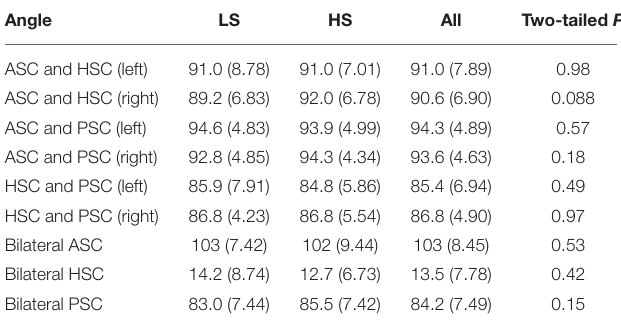
TABLE 1 | Angles between each pair of SCs.